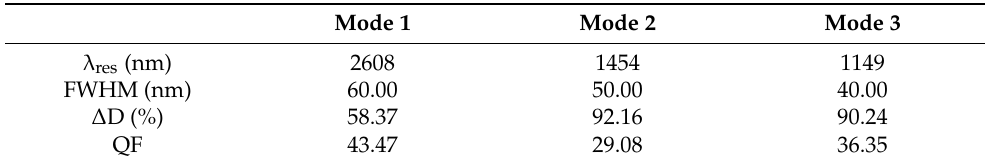
Table 1. Comparison of λ res , FWHM, ∆ D, and QF of the designed structures at corresponding resonance